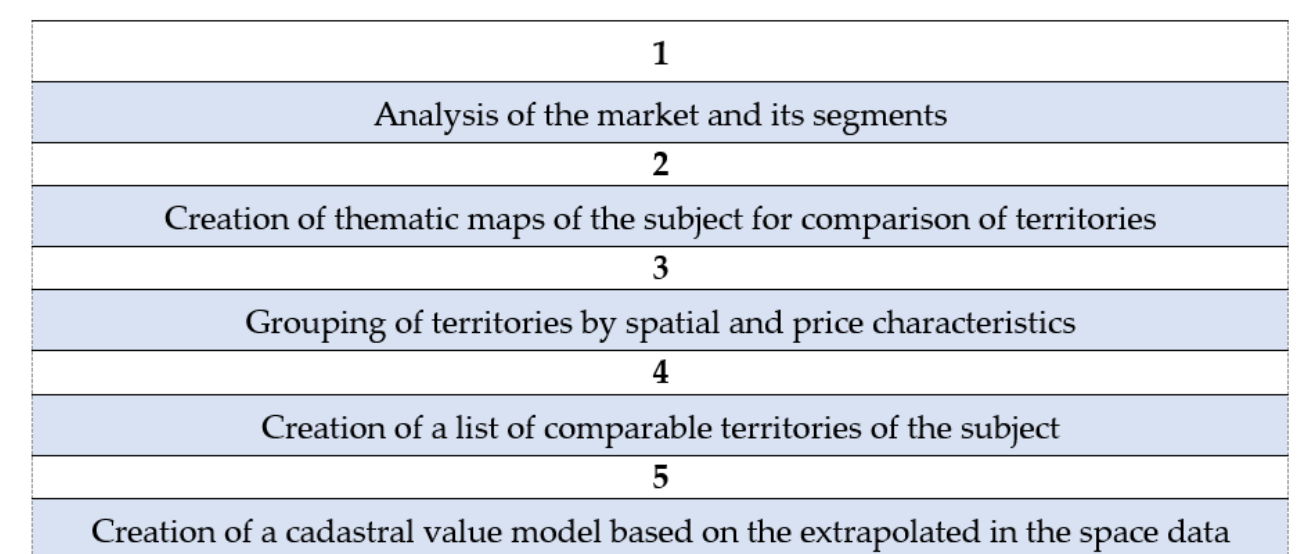
Figure 2. Stages of territorial extrapolation of market data method. Source: Own study.